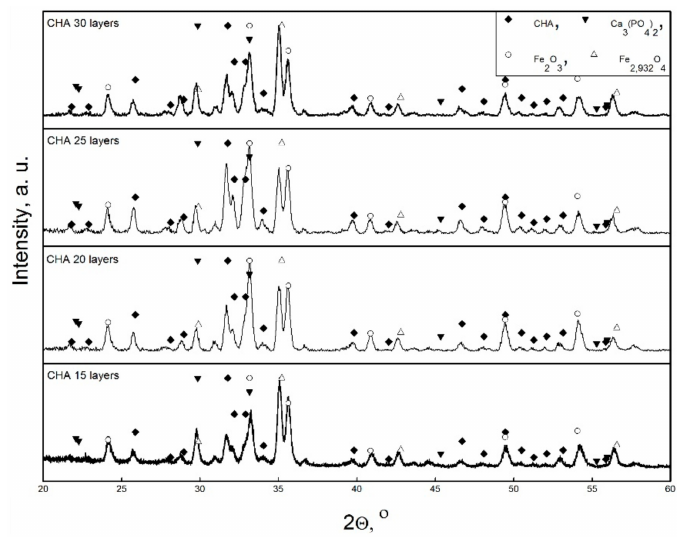
Figure 2. XRD patterns of calcium hydroxyapatite (CHA) coatings fabricated using di ff erent times of spinning and annealing procedures.